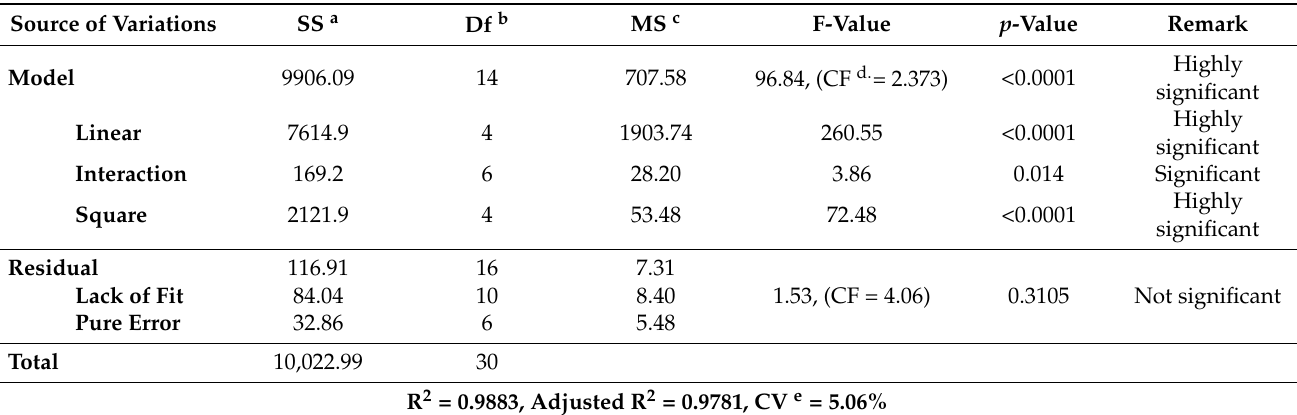
Table 6. ANOVA results for the developed model.